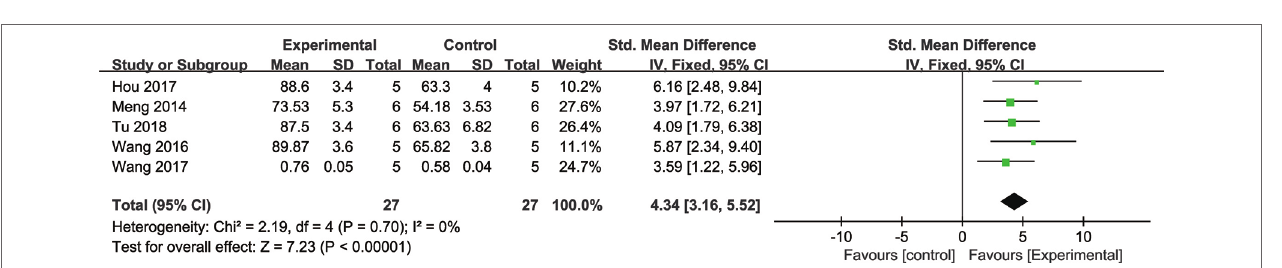
FIGURe 8 | The forest plot: effects of notoginsenoside R1 for increasing cerebral cell viability compared with the control group (n = 27 per group).